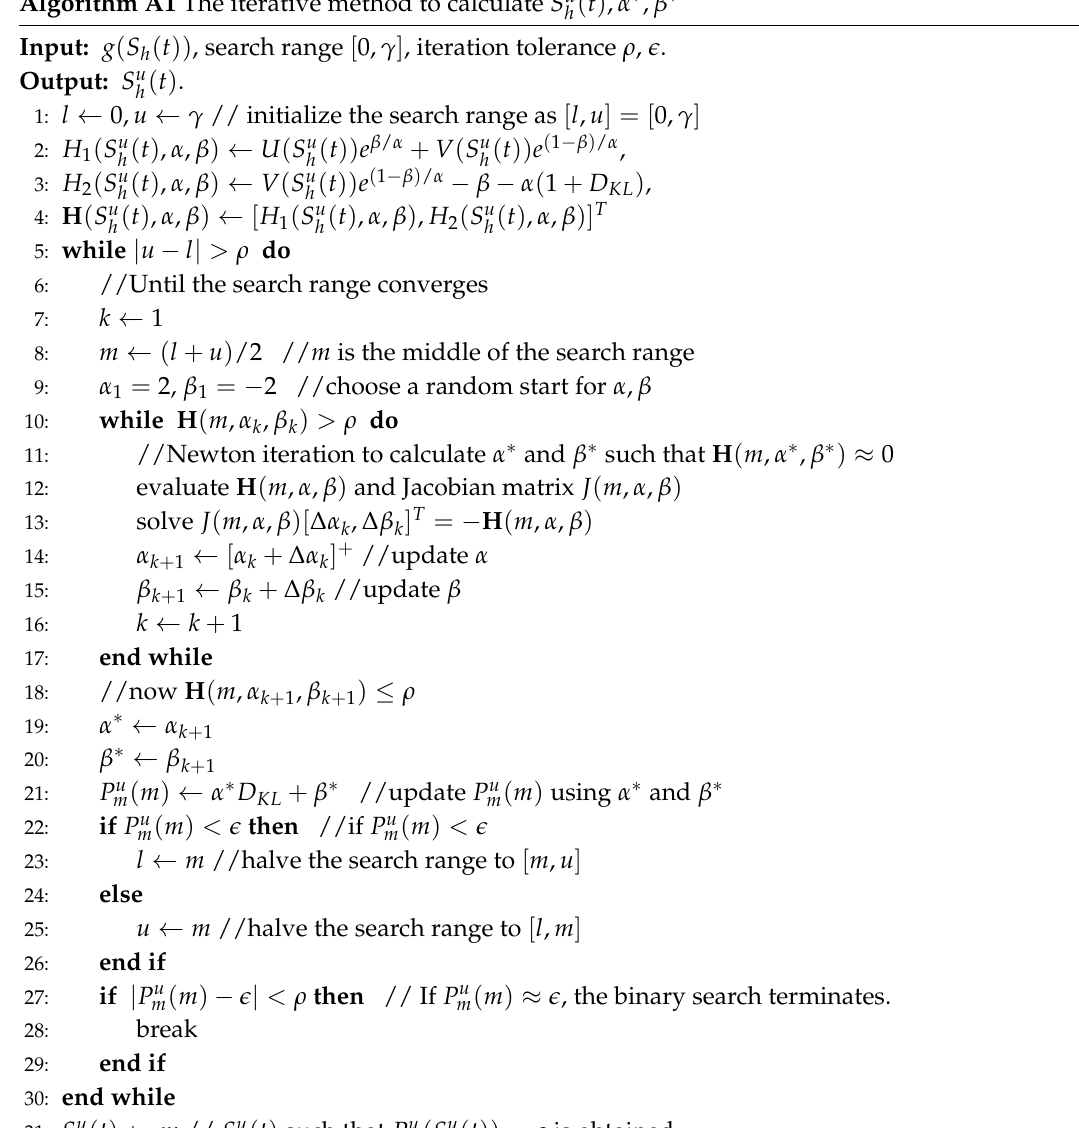
Algorithm A1 The iterative method to calculate S u